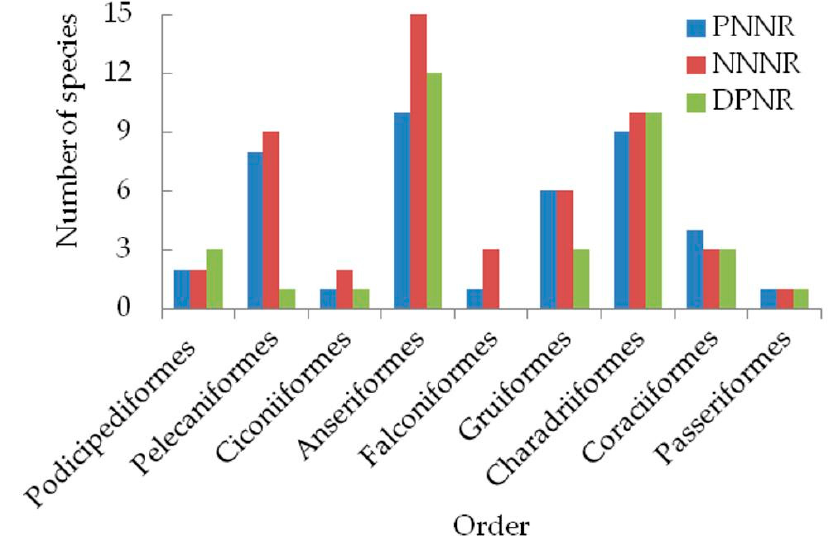
Figure 2. Composition of bird orders in the study site of Poyang Lake.